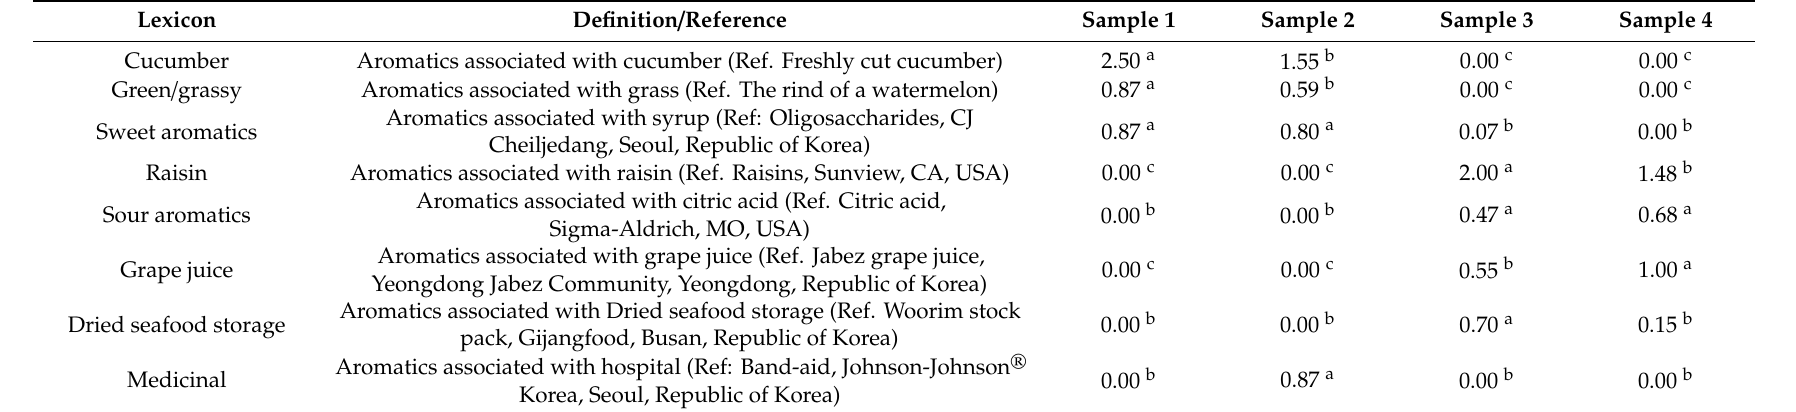
Table 2. Descriptive sensory analysis result on aroma of four mulberries treated in di ff erent